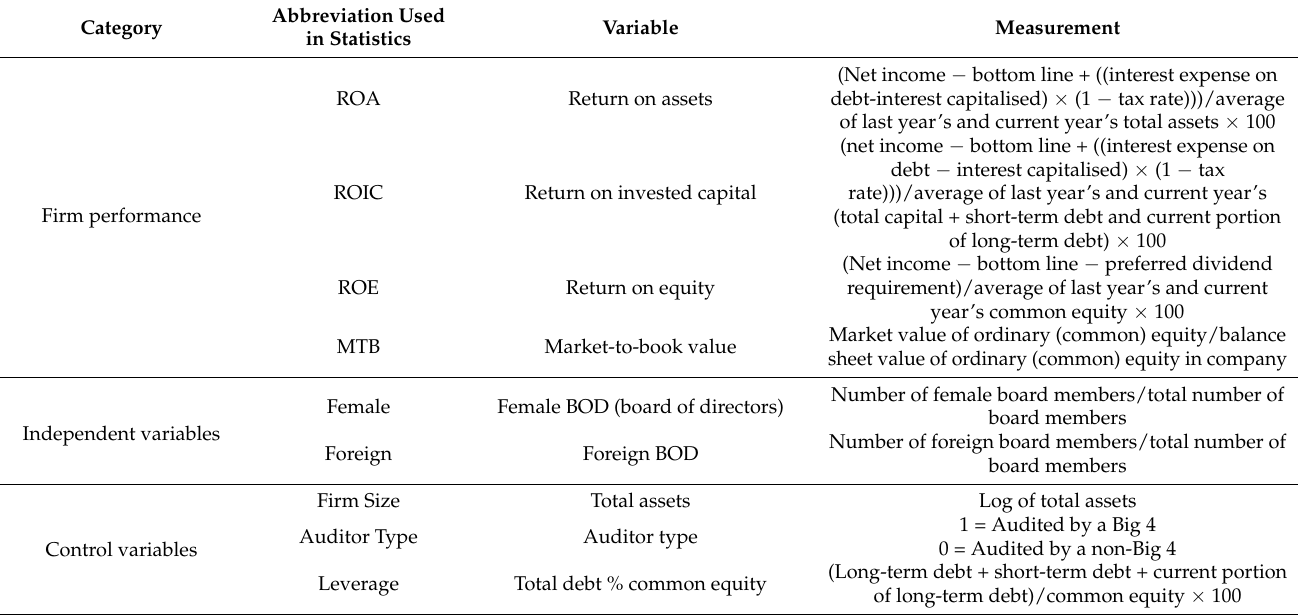
Table 2. Definitions of